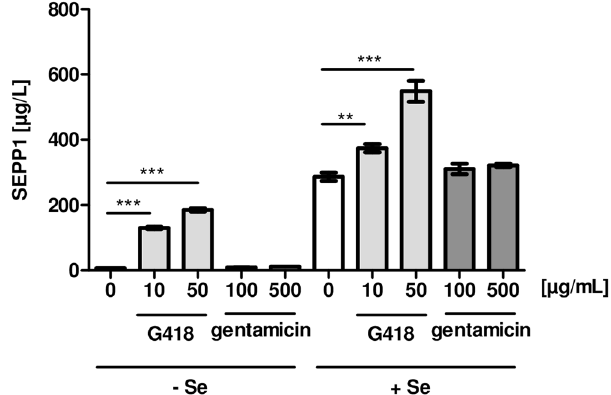
Figure 2. Interplay between AG and supplemental selenite on SELENOP concentrations. HepG2 cells were incubated for 48 h in the presence of G418 or gentamicin with or without supplemental selenite (100 nM). Secreted SELENOP (SEPP1) was quantified by ELISA analyses. G418 strongly induced SELENOP concentrations in the conditioned medium, whereas gentamicin showed no effect. The effect of G418 was augmented by supplemental selenite. (Mean ± SEM, n = 6, ANOVA followed by